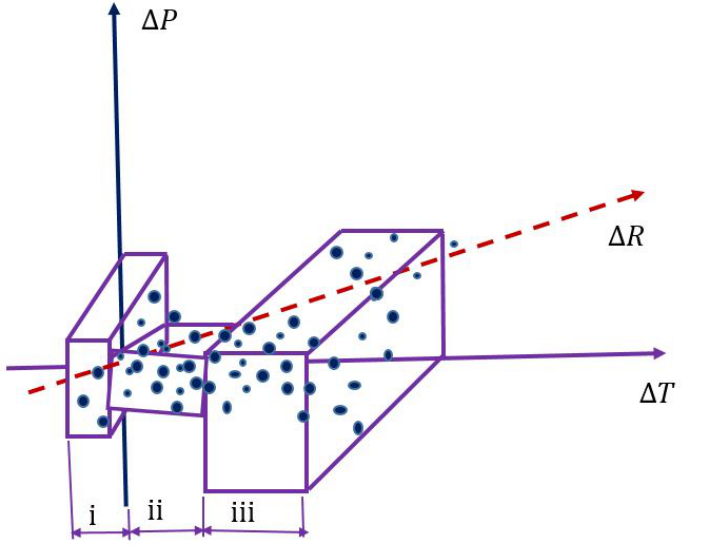
Figure 3. Flexibility requirement by a set of net load deviations over three regulation intervals: ( i ) primary, ( ii ) secondary, and ( iii )